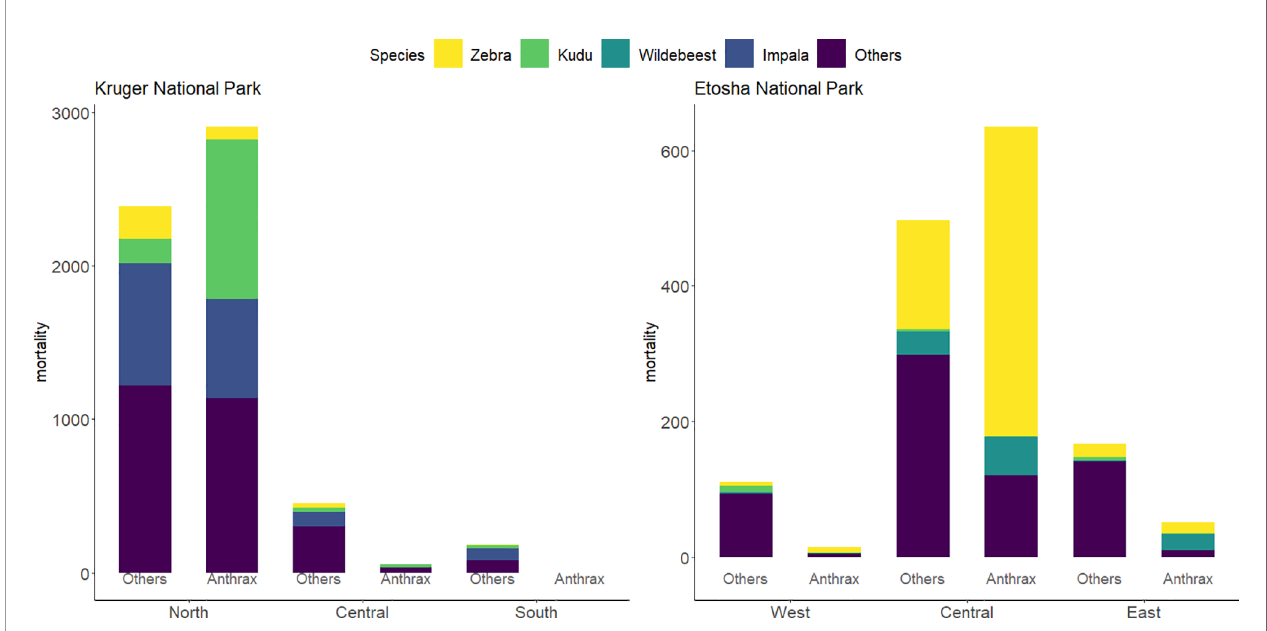
FIGURE 2 | Bar charts of the distribution of mortalities by region and species from 1990-2016 in Kruger National Park (KNP) and from 1996-2016 in Etosha National Park (ENP). Mortalities are group into anthrax or other causes of death. Species of study included greater kudu ( Tragelaphus strepsiceros ), plains zebra ( Equus quagga ), impala ( Aepyceros melampus ), and blue wildebeest ( Connochaetes taurinus ). All other species included 21 species for anthrax mortalities and 57 species for non-anthrax mortalities (others) in KNP and 6 species for anthrax mortalities and 27 species for other mortalities in ENP. Data for KNP were provided by Skukuza Veterinary Services and for ENP from the Etosha Ecological